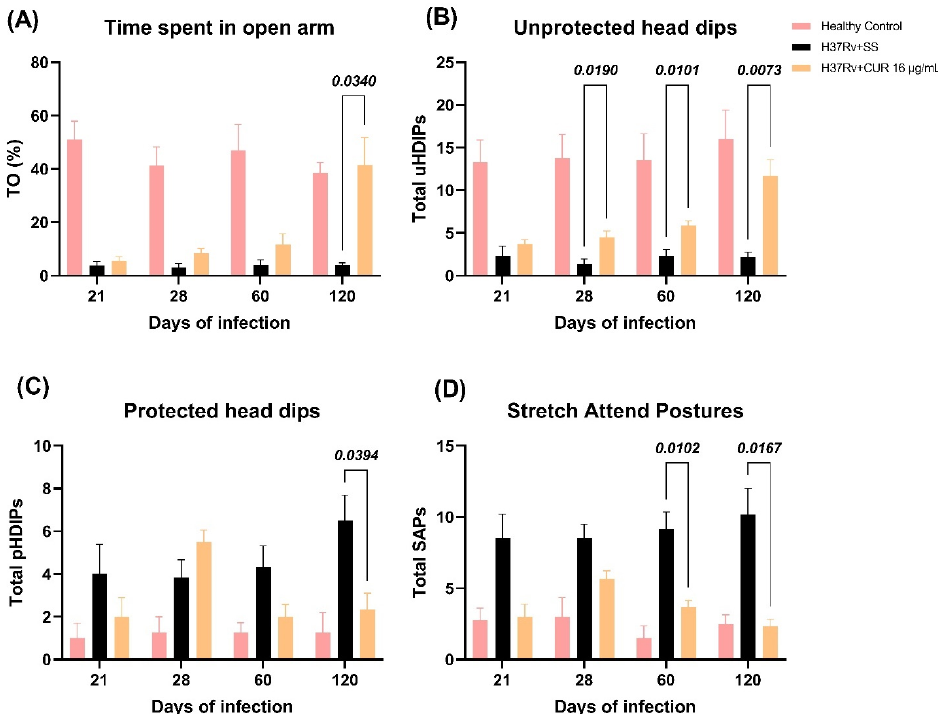
Figure 6. Effect of curcumin (CUR) treatment (16 μ g/mL) on anxiety-like behavior in TB mice eval- uated in the elevated I-maze. ( A ) Time spent on the open arm by infected mice who received CUR,